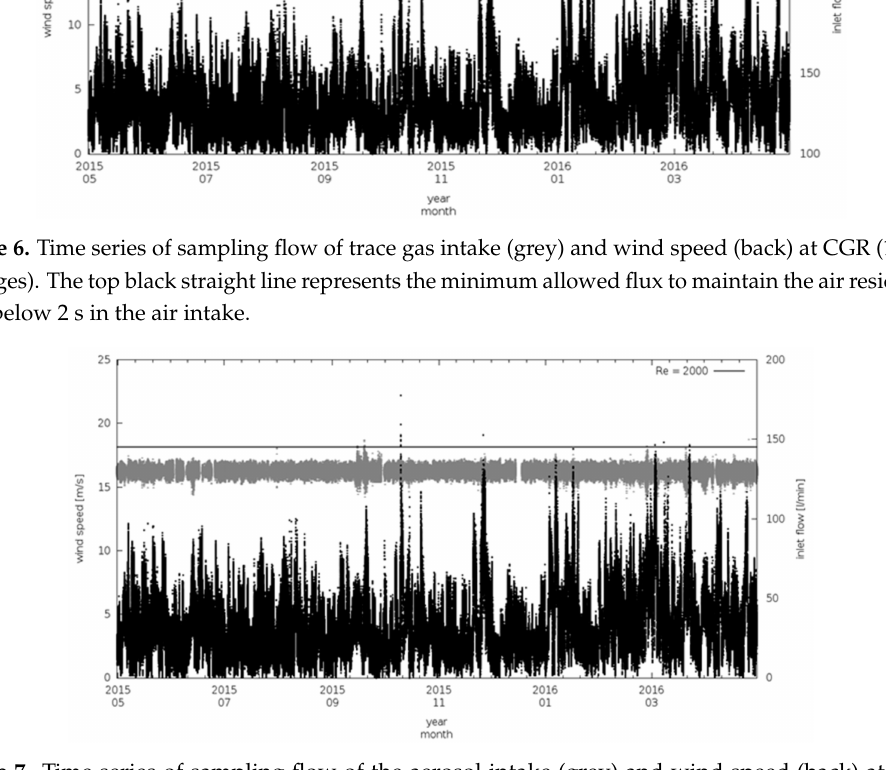
Figure 7. Time series of sampling flow of the aerosol intake (grey) and wind speed (back) at CGR (1-min averages). The top black straight line represents the maximum allowed flux to maintain a laminar regime in the aerosol air